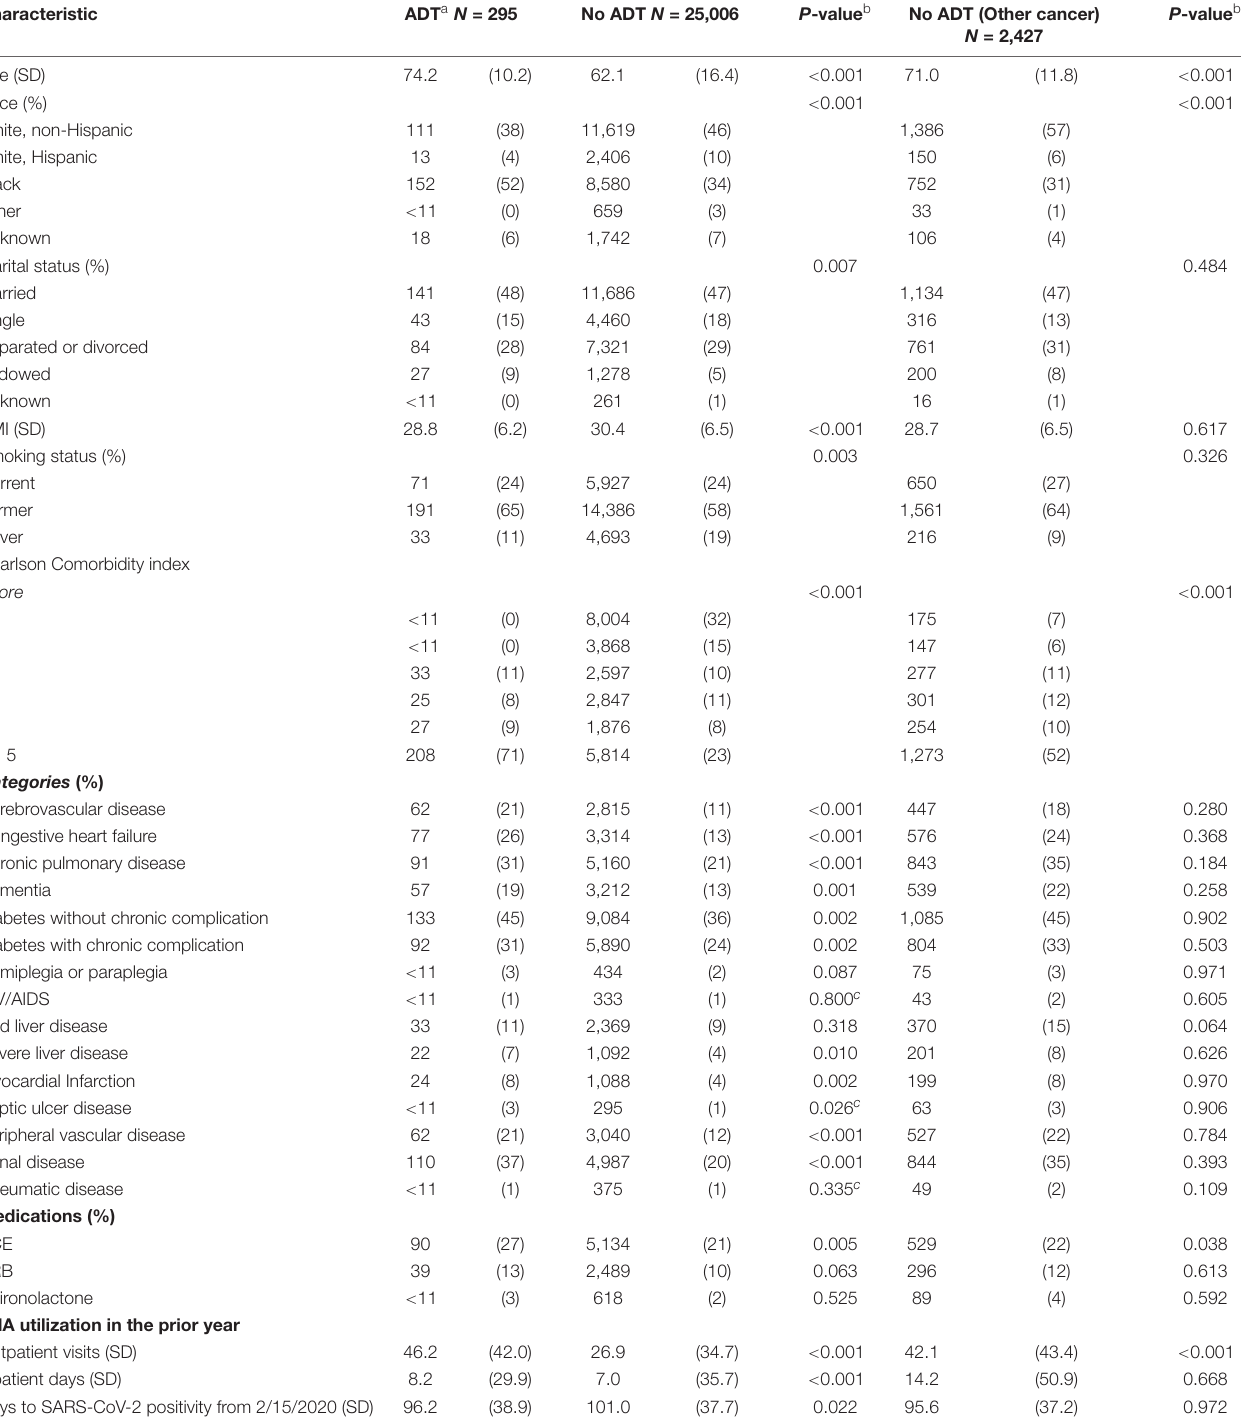
TABLE 3 | Baseline characteristics at first positive SARS-CoV-2